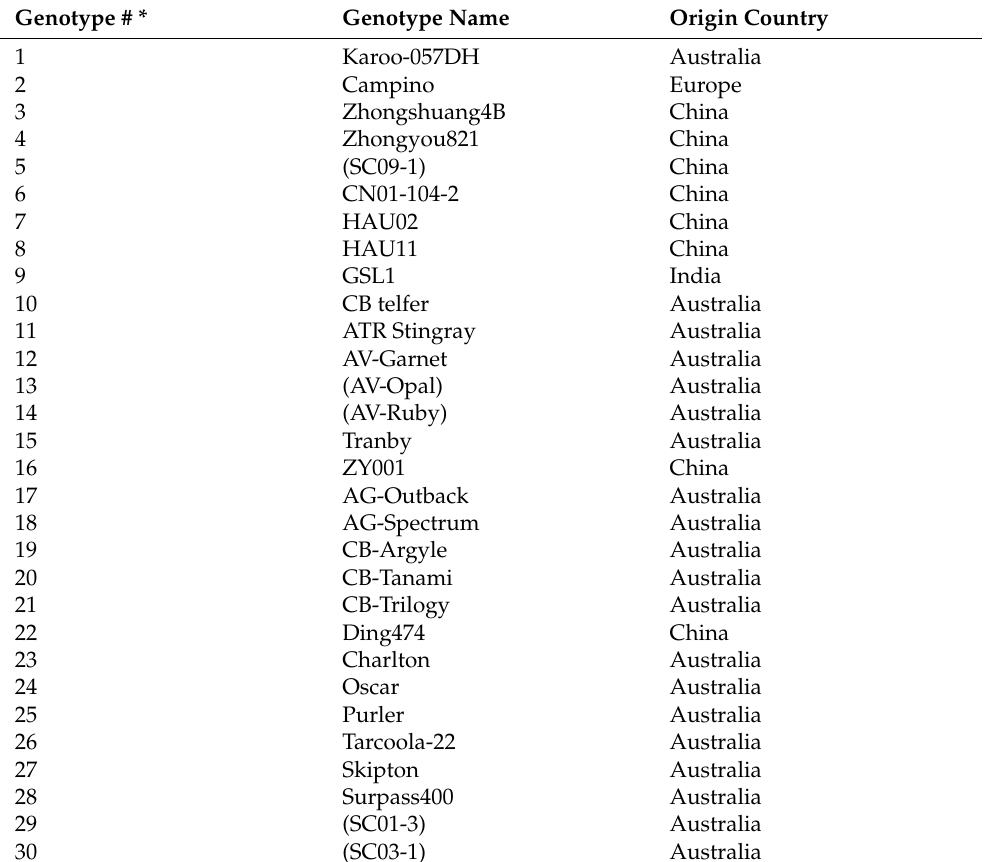
Table 2. Canola genotypes